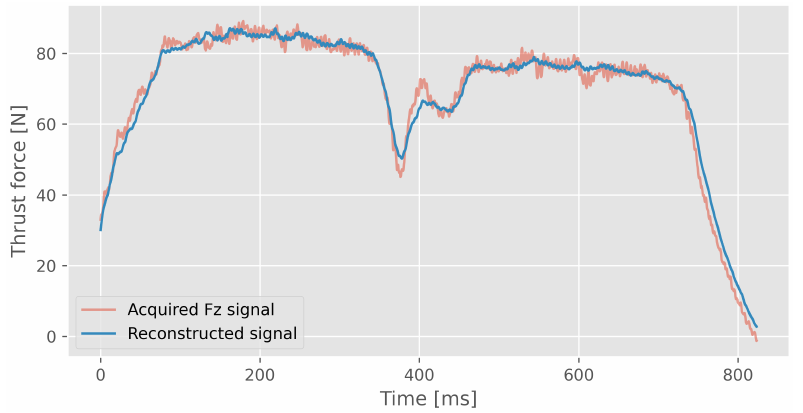
Figure 6. Original and autoencoder-reconstructed thrust force signal for one of the holes executed in the experimental test T4 with process parameters 7500 rpm—0.2 mm/rev.